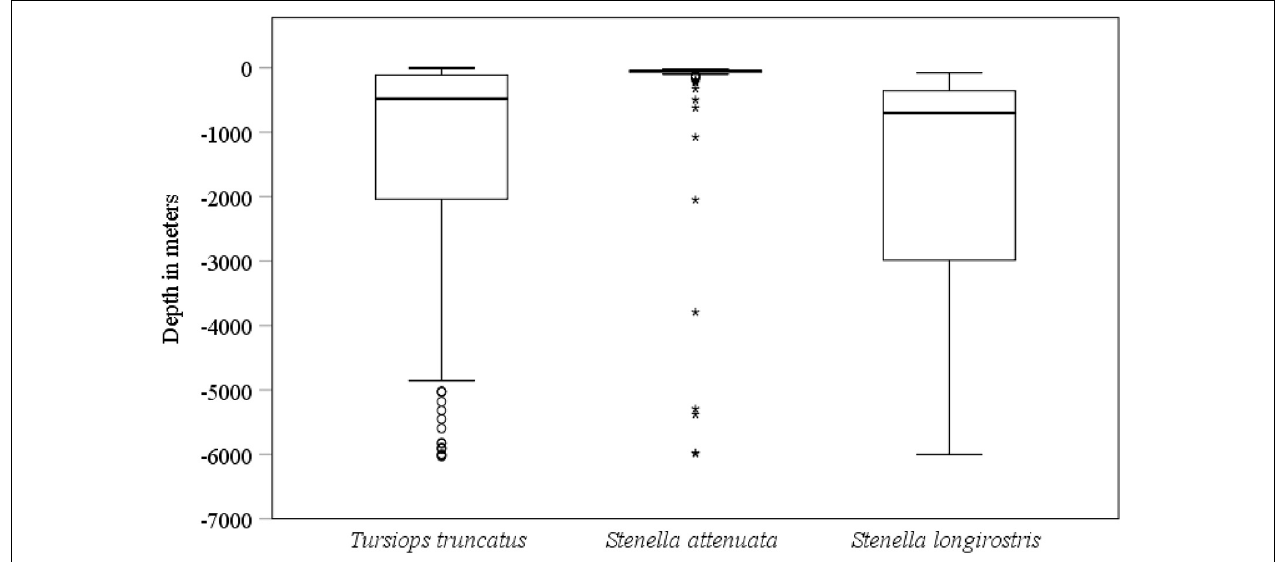
FIGURE 7 | Central tendency and variability of group size of the most common species of small cetaceans identified in the Pacific waters of Guatemala. The solid line drawn across each box represents the median group size. The lower boundary is the 25th percentile and the upper boundary is the 75th percentile of a box. The lines on top and bottom of each box represent the largest and smallest group size, respectively, excluding outliers (o) and extreme values